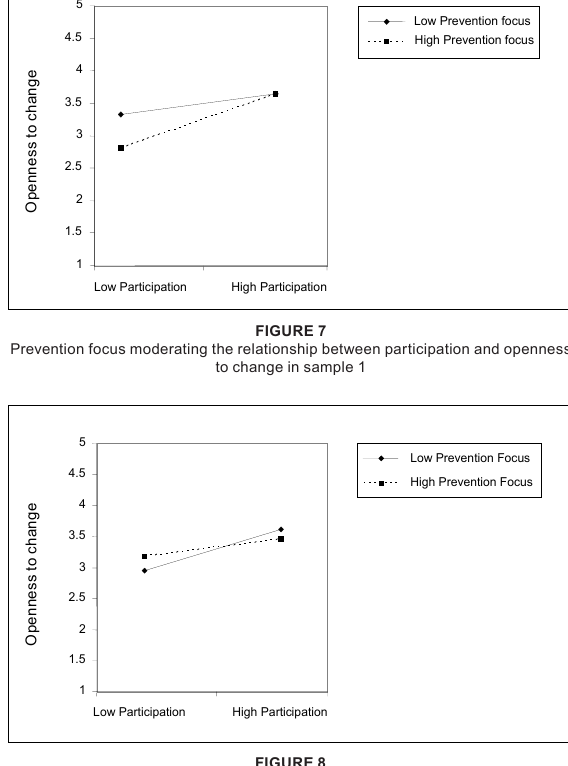
Prevention focus moderating the relationship between participation and openness